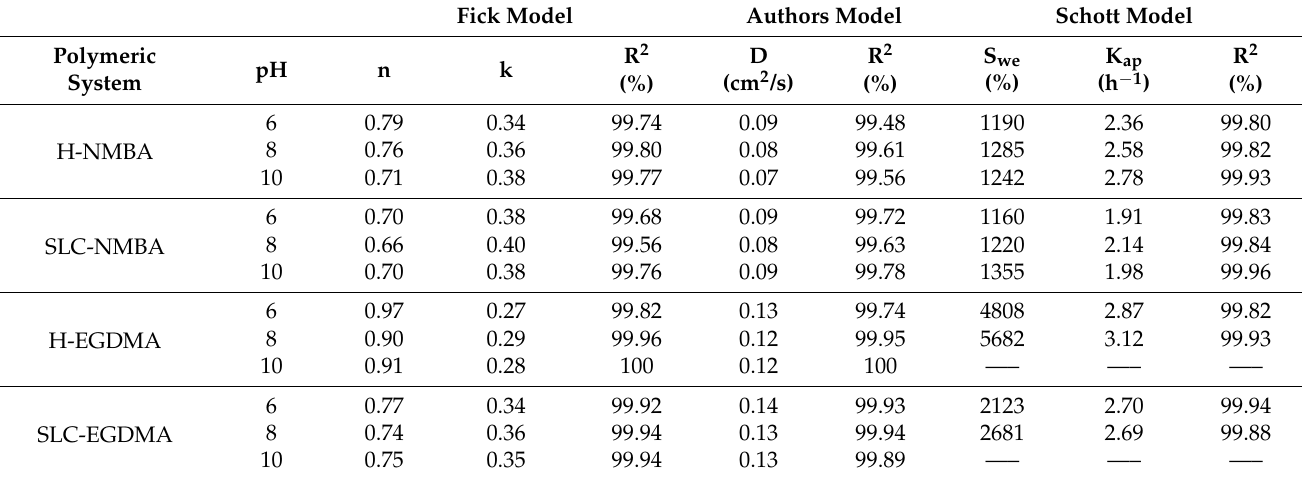
Table 5. Parameters related to diffusion mechanism for the Fick, Authors, and Schott Models a